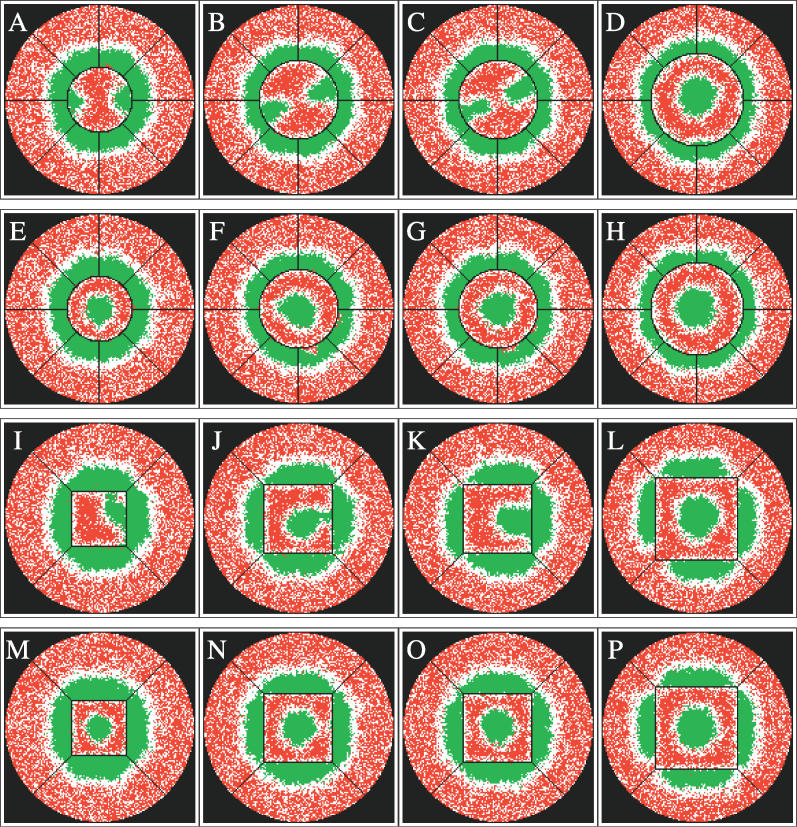
Pattern Transition for Geometrically Repatterned IS: (A–H) with a Circular Geometry and (I–P) with a Quadratic GeometryThe parameters are the same as in Figure 2, and TCR–pMHC complexes (green), LFA-1–ICAM-1 complexes (red), and chromium barriers (black) are shown.(A–D) and (I–L) TCR–pMHC aggregation due to long-range attractive interaction (Latt = R, watt = 0.14, wdir = 0).(E–H) and (M–P) TCR–pMHC aggregation due to centrally directed motion (Ldir = R, wdir = 3, watt = 0). The radius of the circular geometry and the simulation time are (A) and (E) r = 0.36R after 30 min, (B) and (F) r = 0.43R after 30 min, (C) and (G) r = 0.43R after 60 min, (D) and (H) r = 0.50R after 30 min. The side length of the quadratic geometry and the simulation time are (I) and (M) s = 0.57R after 30 min, (J) and (N) s = 0.71R after 30 min, (K) and (O) s = 0.71R after 60 min, (L) and (P) s = 0.85R after 30 min.